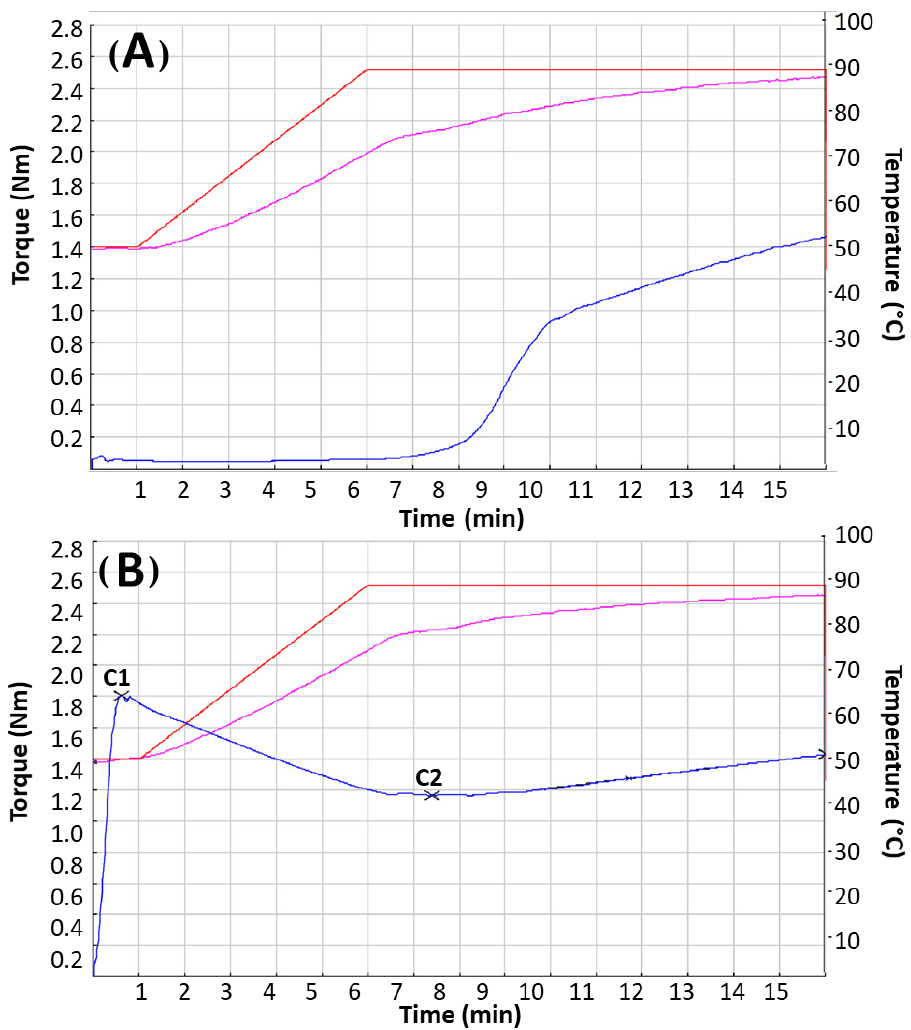
Figure 2. Mixolab profile of native ( A ) and extruded-cooked ( B ) lentil flour. The red line indicates the variation of Mixolab temperature setting, the violet line indicates the variations of the actual temperature of the dough, and the blue line indicates the variations of torque. C1 = maximum torque at the beginning of the analysis, C2 = minimum torque while the dough was subjected to mechanical stress.